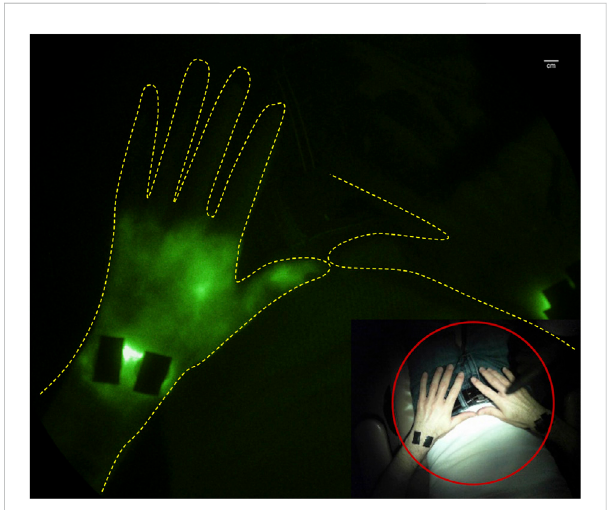
FIGURE 7 Retrograde lymph fl ow and dermal back fl ow in left hand of subjectwithjointpainasvisualizedwithNIRF-LI(from studypublished in (Aldrich et al., 2020)).